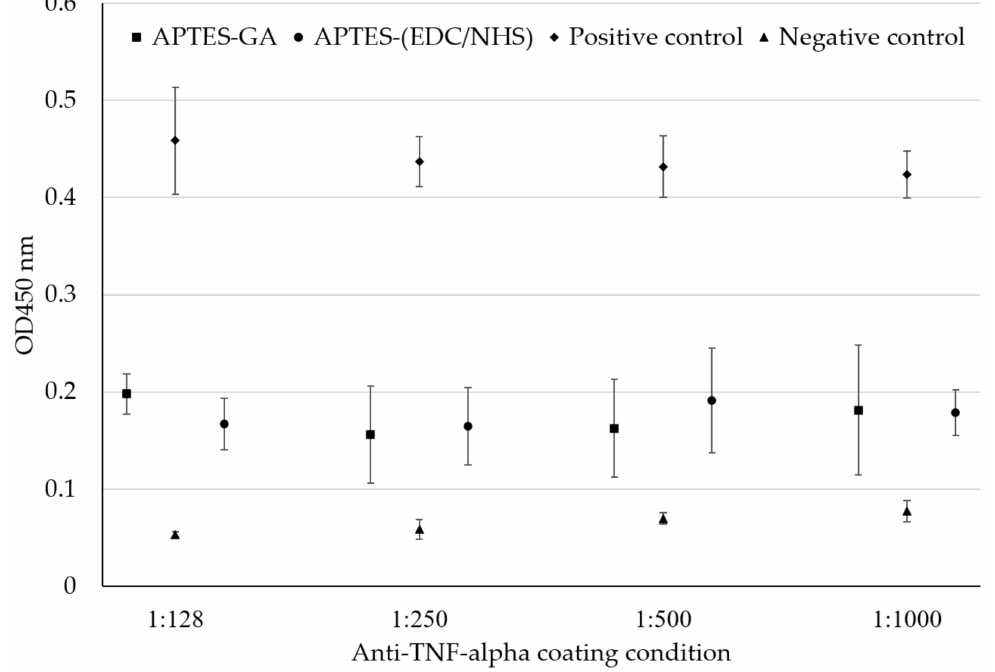
Figure 12. ELISA results of anti-TNF-alpha coated Si chips using the two techniques ( n = 5). Positive control: anti-TNF-alpha coated well, tested with antigen. Negative control: anti-TNF-alpha coated well, tested without